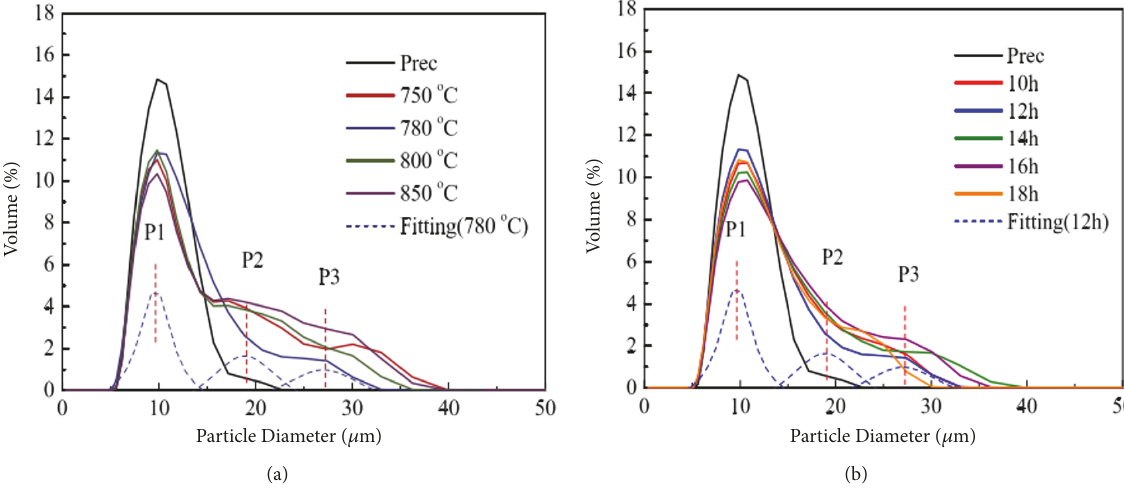
Figure 5: Particle size of NCM622 prepared by solid state reaction at (a) sintering temperatures and (b) sintering times [29]. Copyright: Ceramics International.